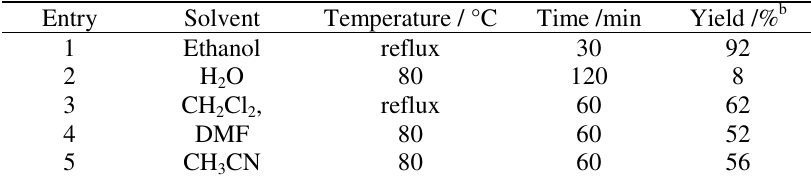
Table 2. Solvent optimization for the synthesis of 4a a